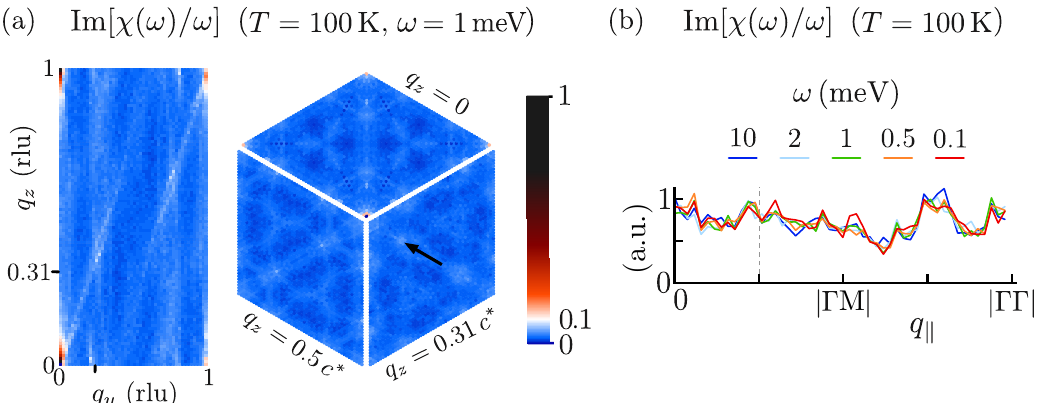
Figure 5: (a) The magnitude of the nesting function Im [ χ ] /ω , with χ ( q , ω ) the Lindhard function and ω = 1 meV. The rectangular figure is in the q = 0, while the hexagonal figure shows the function in the q q x different values of q . The ticks on the axes of the rectangular figures indicate the z location of the observed CDW ordering wave-vector, also indicated by black arrows in the hexagonal figures. Note the lack of a significant peak at this position. (b) The nesting function for q along the black arrow shown in (a), for different values of ω